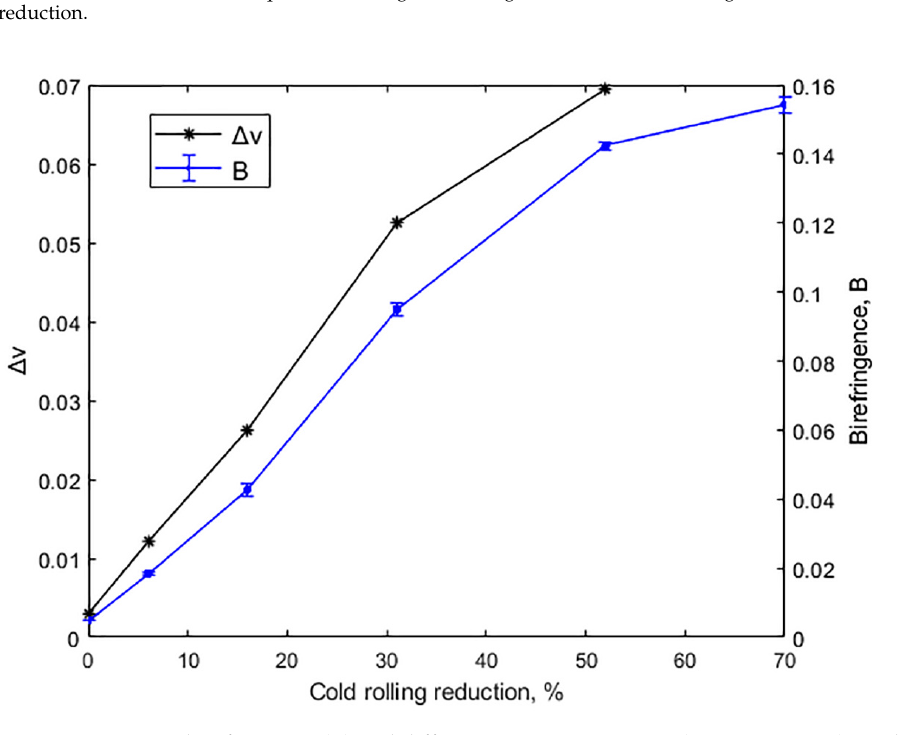
Figure 5. Acoustic birefringence ( B ) and difference in Poisson’s ratio ( ∆ ν = ν 32 − ν 31 ) vs. thickness reduction by cold rolling.